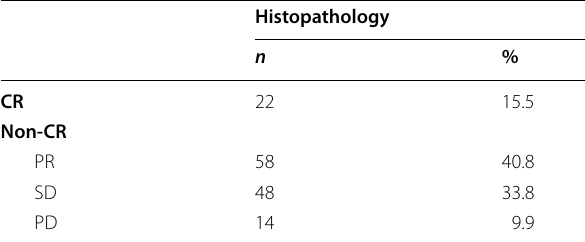
Table 3 Treatment response to NAC by histopathology